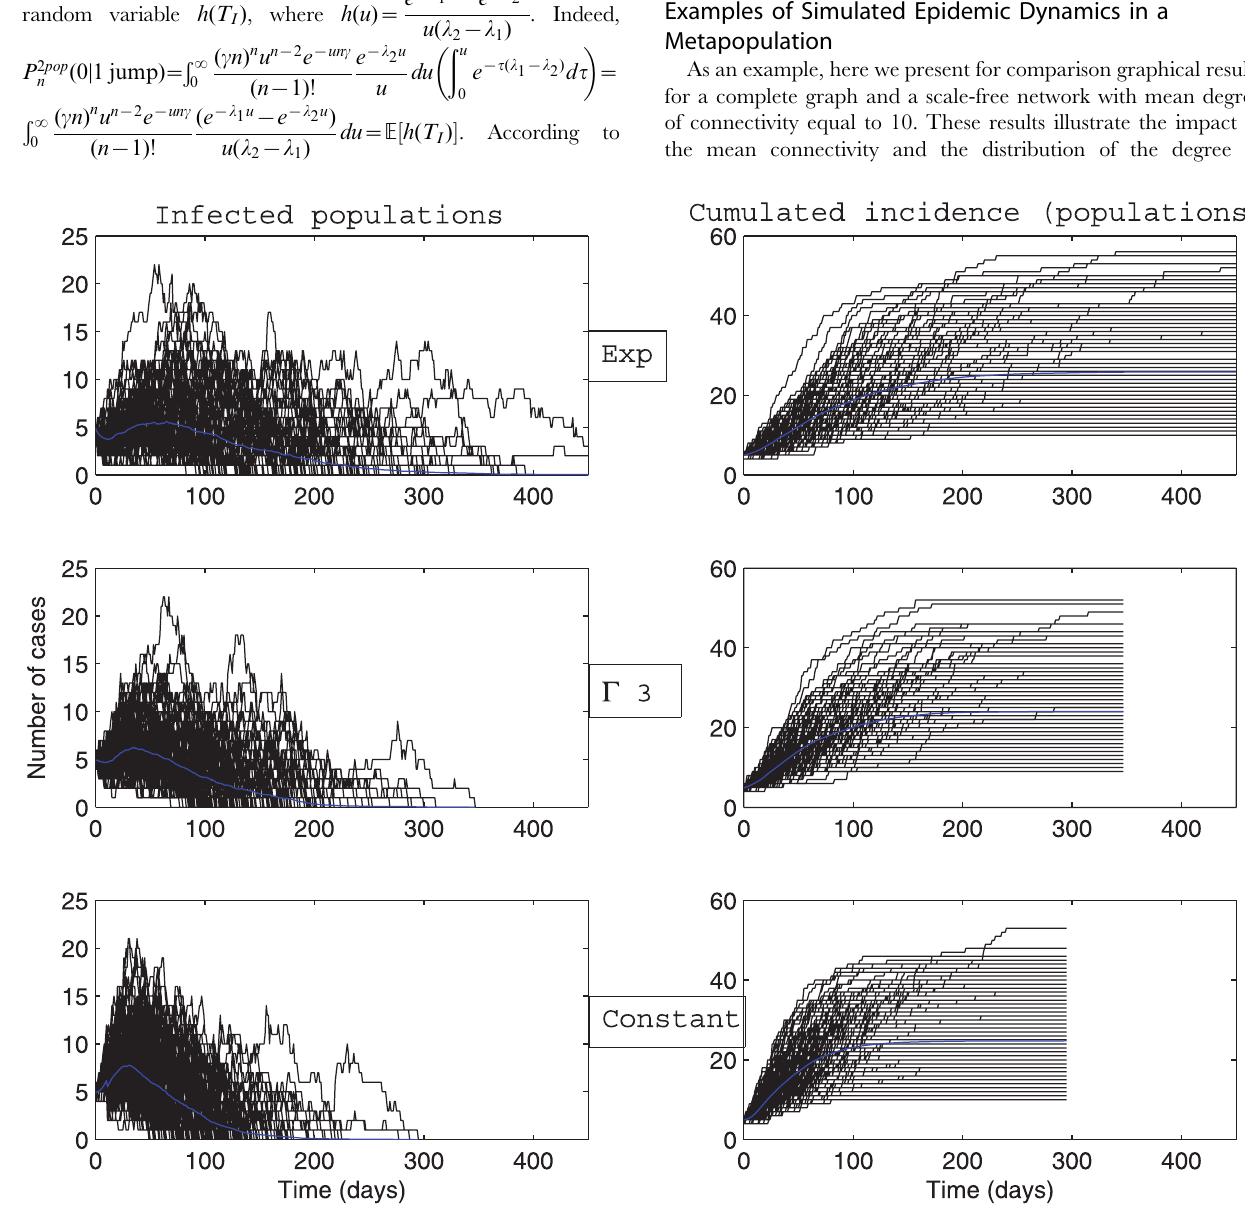
Figure 6. Dynamics of infected populations and cumulative incidence (in number of populations) described by a stochastic metapopulation model based on a scale-free network with mean degree of connectivity equal to 10. Early extinct trajectories were not considered. The mean (blue curve) was calculated over major epidemics only (corresponding to a final attack rate greater than 5 % ). Simulations are performed using a time-continuous event-driven approach with T I * Exp( c ) (top panel), T I * C (3,3 c ) (middle panel) and T I ~ Const ~ 1 = c (bottom panel). Parameters values are given in the subsection Examples of Results.